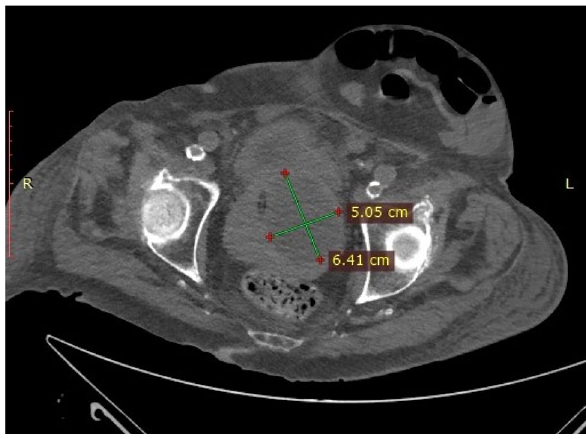
Fig. 2 CT scan of the pelvis showing a left paramedian intraprostatic collection measuring 64 × 54 × 50 mm, with no evidence of extrapro- static